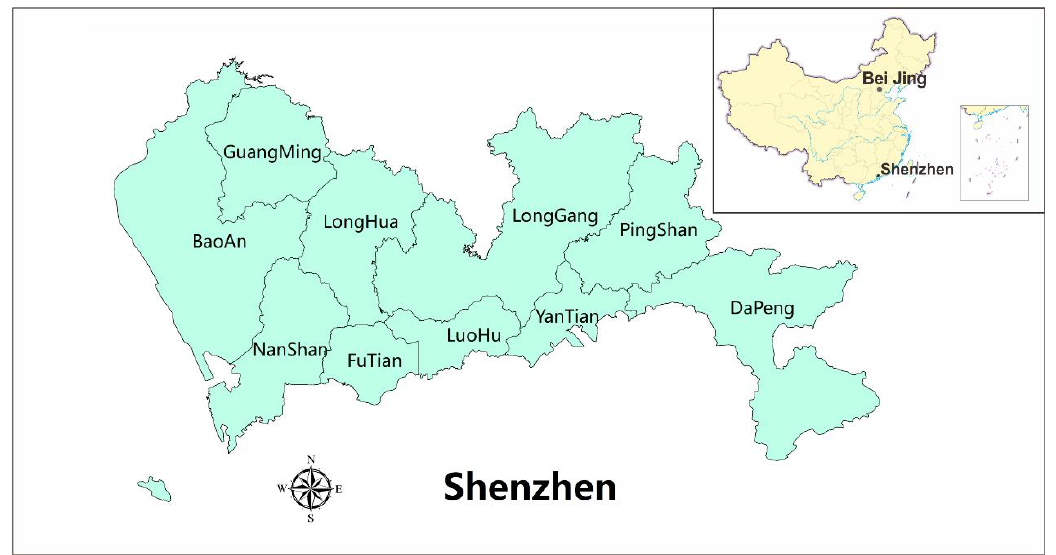
Figure 1. Location of Shenzhen in China and Districts in Shenzhen.